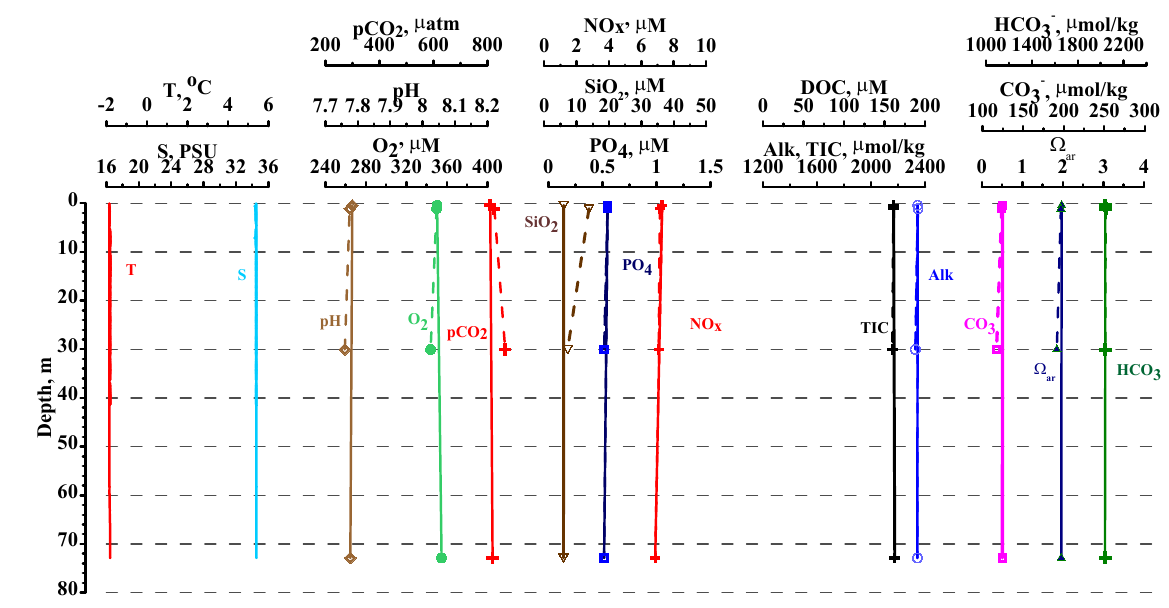
Figure 2. Vertical distribution of the temperature, T, salinity, S, pH, pH, dissolved oxygen, O 2 , phosphate, PO 4 , nitrate, NO x , silicate, SiO 2 , dissolved organic carbon, DOC, total alkalinity, Alk, total inorganic carbon, TIC, carbonate, CO 3 , partial pressure of CO 2 , pCO 2 , and aragonite saturation (Arag. Sat.) at the station near the glacier T1 (dotted line) near the outlet T7 (solid line), sampled on 19/02/2011.